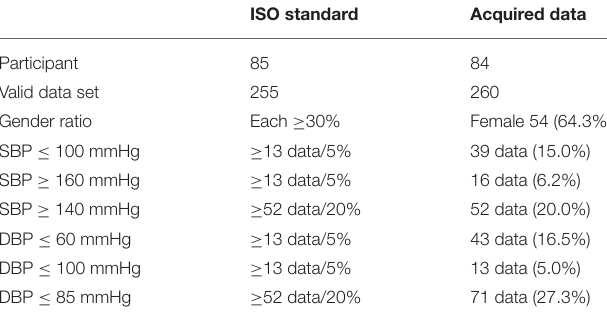
TABLE 2 | Blood pressure distribution of participants.